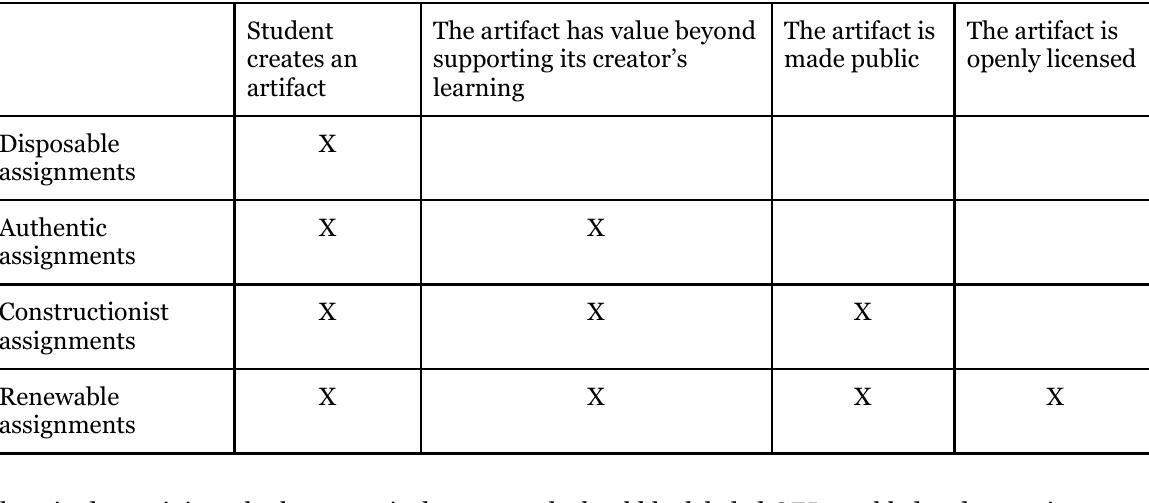
Criteria Distinguishing Different Kinds of Assignments